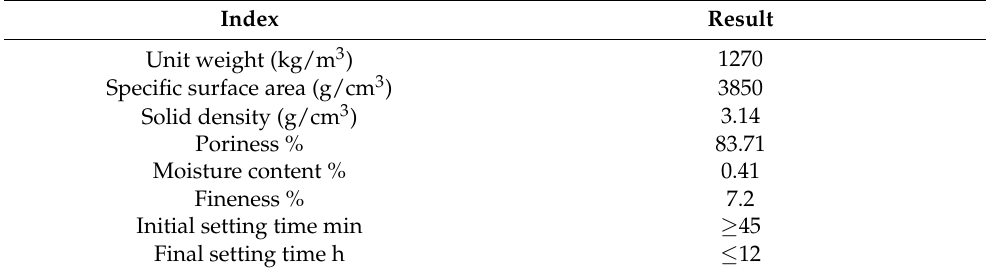
Table 1. Physical properties of cement.